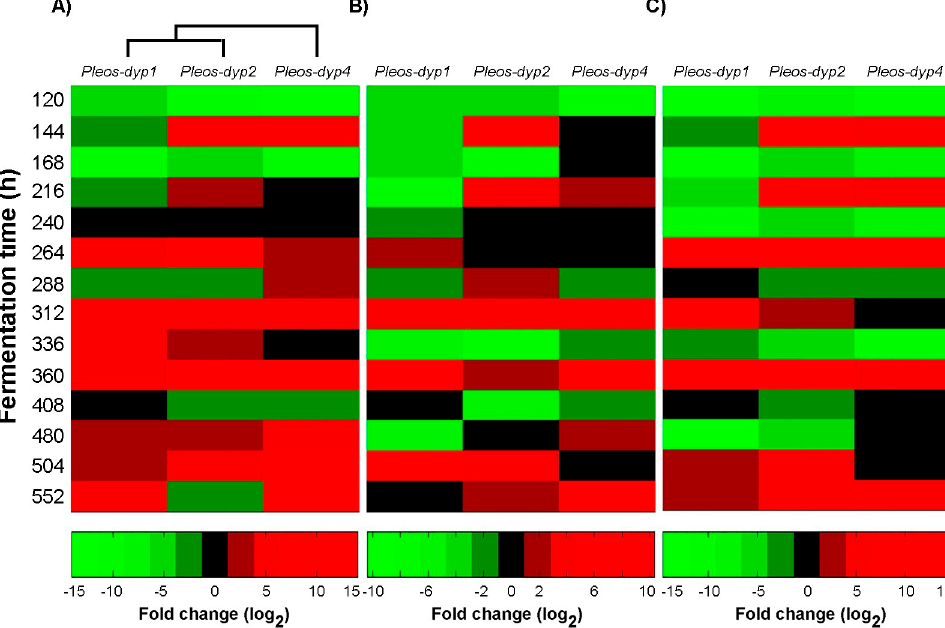
Fig 2. Heat map of global gene expression. Exploratory analysis of the gene expression of three Pleos-dyp genes during the time-course of the submerged fermentation of Pleurotus ostreatus containing (A) AYG, (B) RBBR and (C) AB129